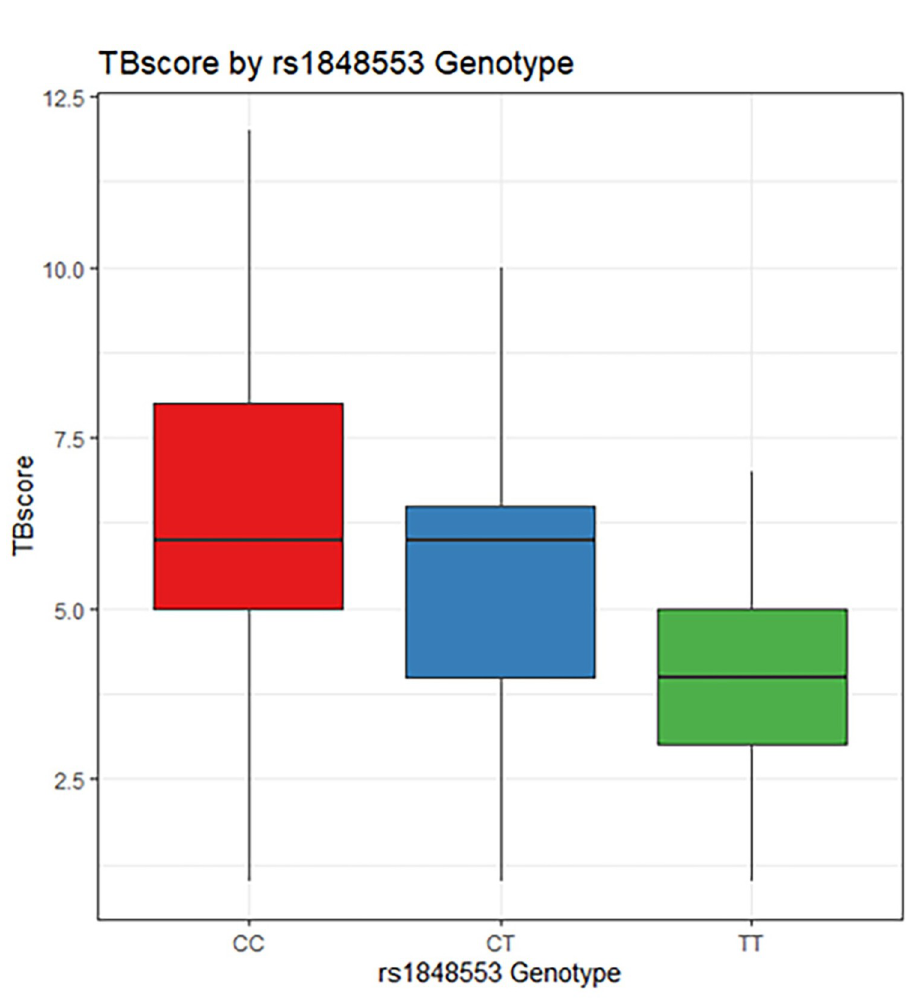
Fig 4. Boxplot of TBscore by rs1848553 (GWAS significant SNP) genotype. Distribution of TBscore by genotype.